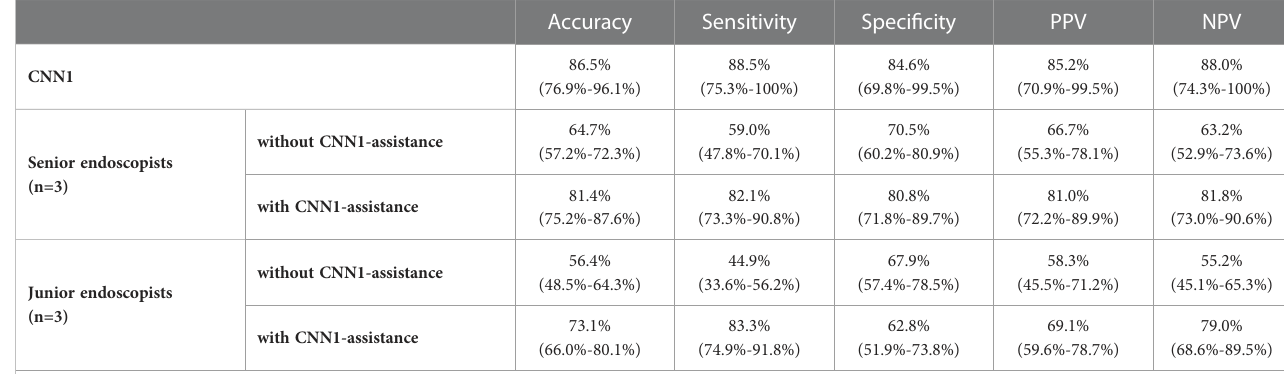
TABLE 6 Comparison between CNN1 and endoscopists for the diagnosis of LGIN.